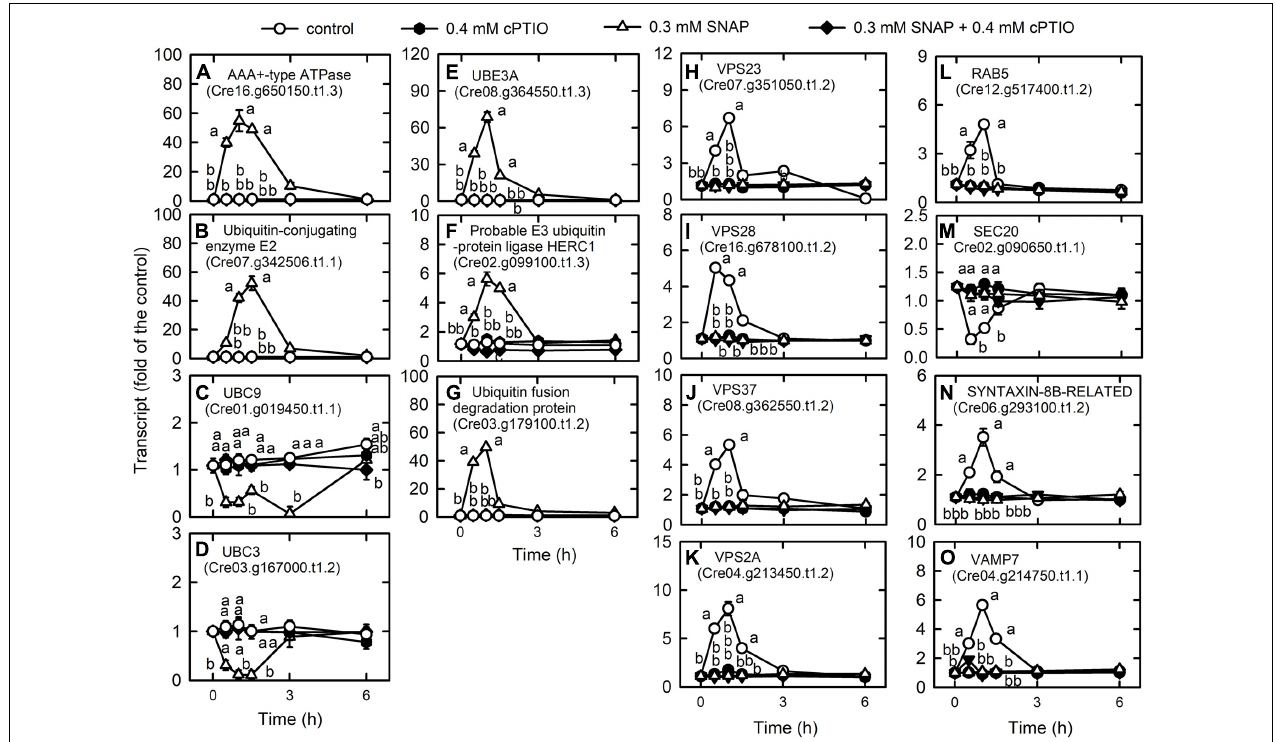
FIGURE 5 | Effects of NO on the expression of genes encoding proteins associated with membrane trafficking system. Time-course changes in the transcript abundances of AAA + -type ATPase (A) , ubiquitin-protein ligase E2 (B) , UBC9 (C) , UBC3 (D) , UBE3A (E) , probable E3 ubiquitin-protein ligase HERC1 (F) , ubiquitin fusion degradation protein (G) , VPS23 (H) , VPS28 (I) , VPS37 (J) , VPS2A (K) , RAB5 (L) , SEC20 (M) , SYNTAXIN-8B-RELATED (N) , and VAMP7 (O) in C. reinhardtii after exposure to 0.3 mM SNAP in the presence or absence of 0.4 mM cPTIO. Data are expressed as the mean ± SD ( n = 3). Different symbols indicate significant differences between treatments (Scheffe’s test, P <